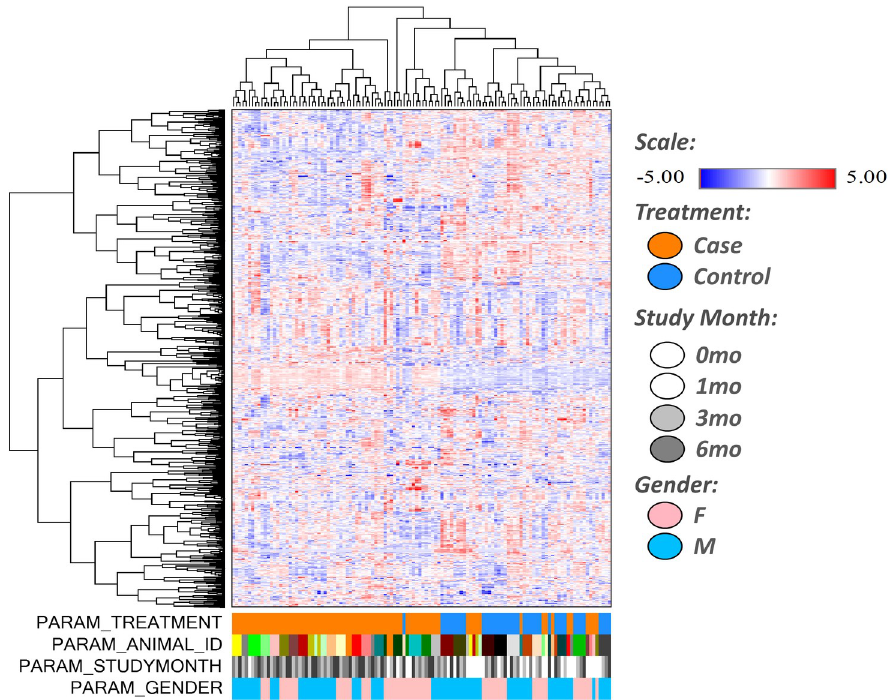
Fig 3. Hierarchical clustering analysis involving 819 biochemicals detected in the dolphin serum metabolome, including large-scale effects of the metabolome among dolphins on the modified wild-type fish diet (‘Case’) compared to dolphins on the baseline fish diet (‘Control’) (solid orange